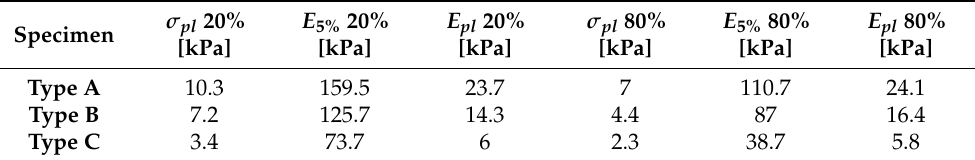
Figure 3. Comparison of the experimental and numerical axial stress–strain ( a ) and transverse vs. axial strain ( b ) curves obtained at 80% strain while considering ν = 0 and ν ≠ 0. Tangential Poisson’s function ( c ) and specific strain energy ( d ) for 20% and 80% strain. Table 3. Plateau stress σ pl and modulus of elasticity E 5% up to 5% of deformation and the plateau modulus E pl for the first and fourth compression cycles (20% and 80% of deformation).